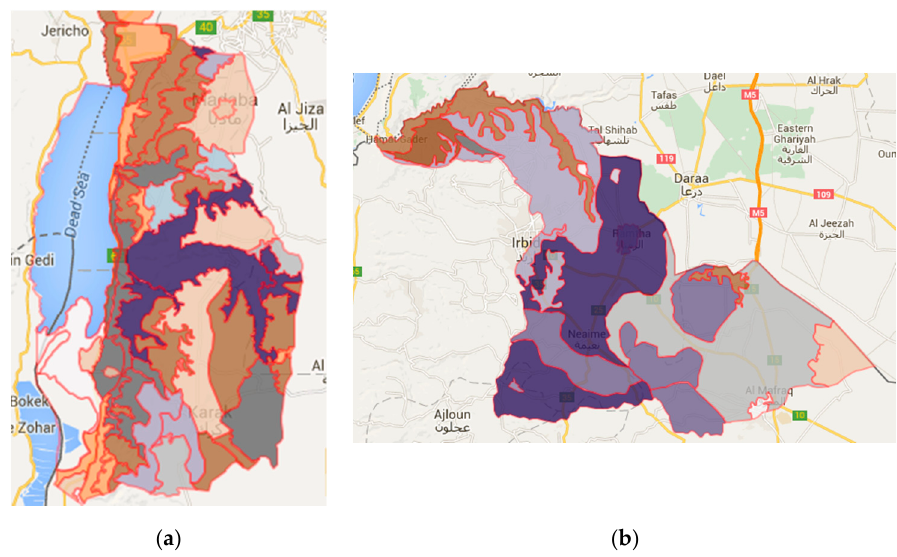
Figure 18. Landscape Risk Assessment (LRA) maps for the two areas in Jordan: ( a , b ).